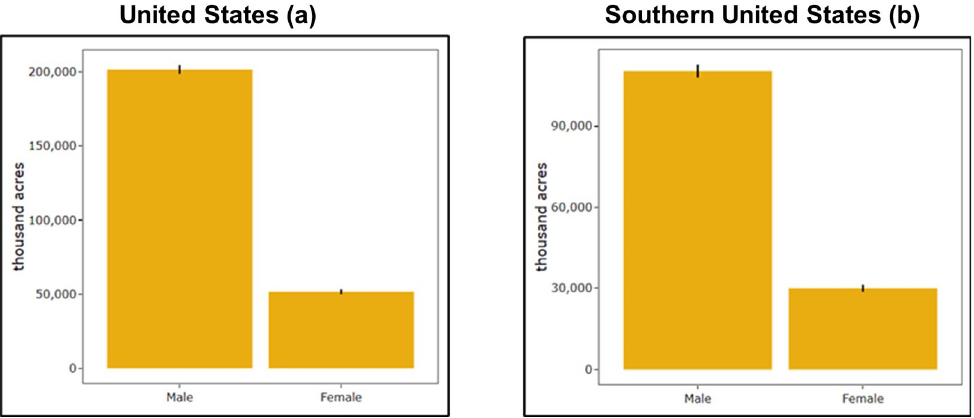
Fig 1. Gender representation in privately owned forestland